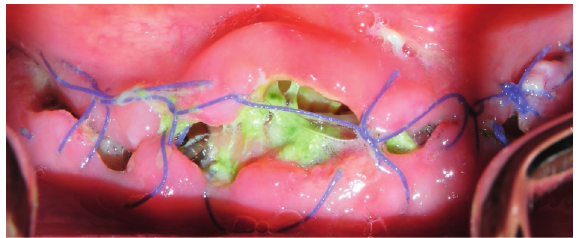
Figure 8: Infectious process with rupture of the suture material.